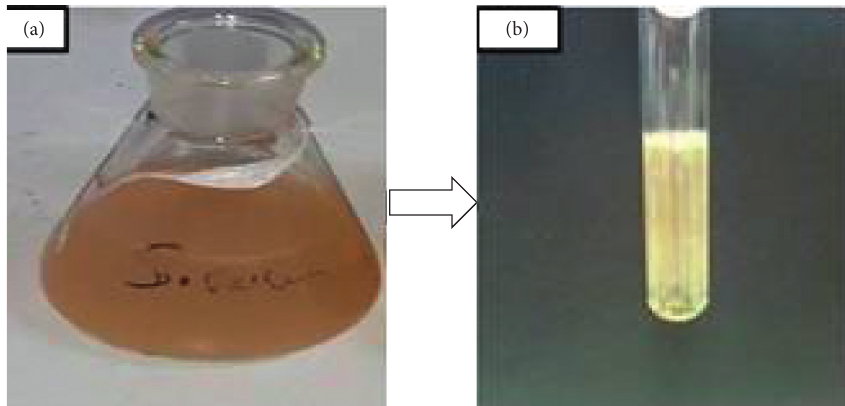
Figure 4: (a) Gram-negative and Gram-positive bacteria. (b) Putting the sample in a solution of 0.1ml bacteria and 9.9ml distilled water.